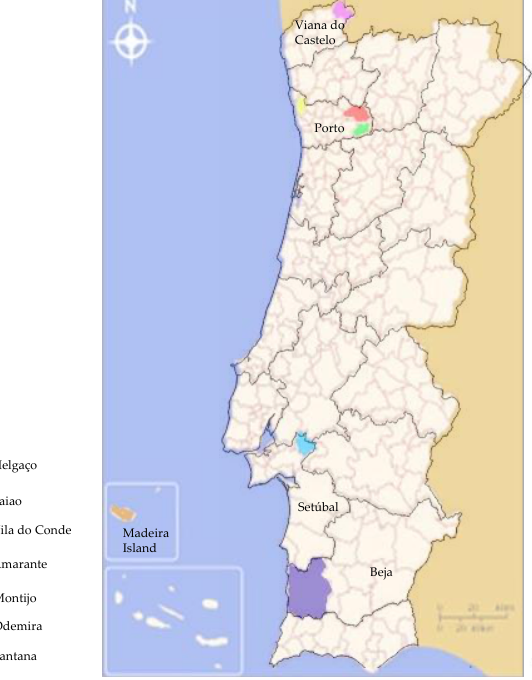
Figure 1. Counties and districts where Meloidogyne hapla was detected.